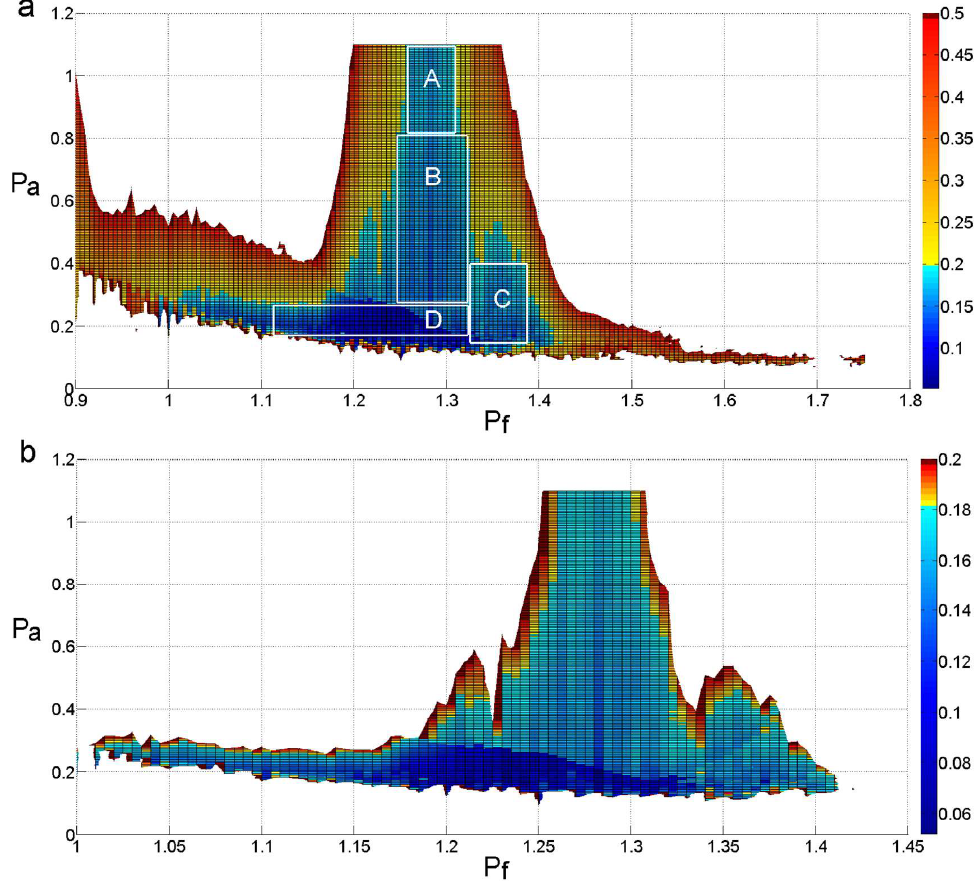
Figure 11. The distribution of the NMSE. ( a ) The distribution of the NMSE that less than 0.5; ( b ) The distribution of the NMSE that less than 0.2. distribution of the NMSE that less than